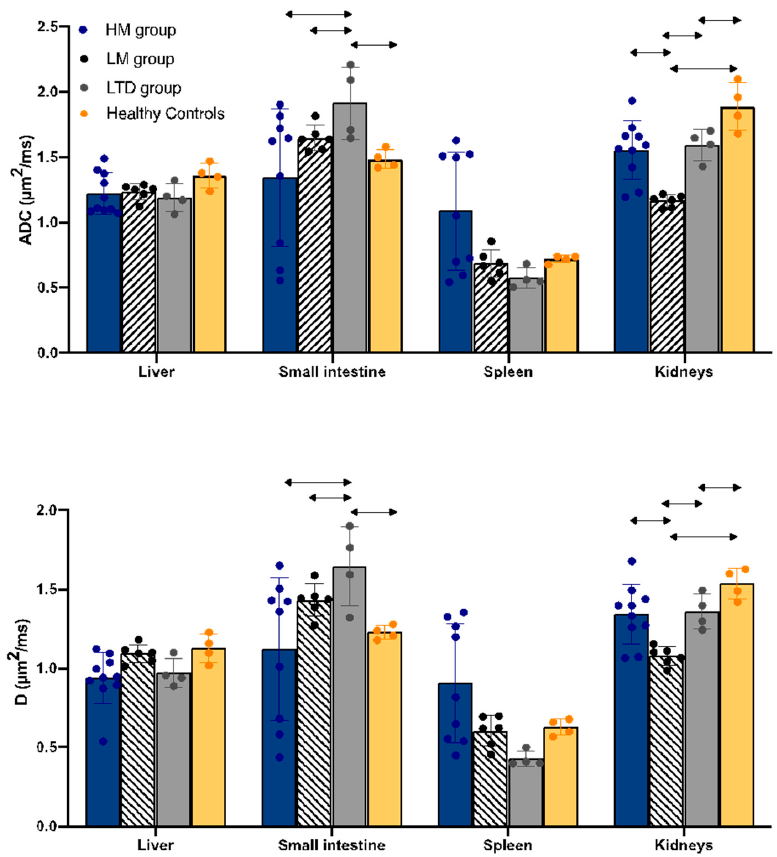
Figure 5. ADC ( upper part ) and D ( lower part ) per organ per group. The arrows represent statistically significant differences between the groups.